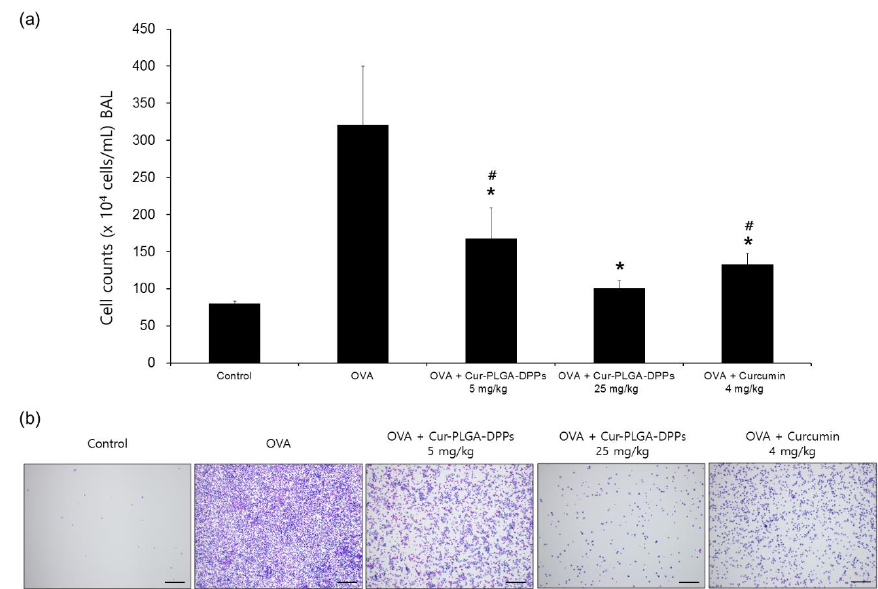
Figure 5. Effect of Cur-PLGA-DPPs on total cells in BALF; ( a ) total cell numbers and ( b ) representative photograph of BALF cells obtained through centrifugation and stained using Diff-Quick. Asterisks indicate a significant difference from the OVA group. Data are shown as mean ± standard deviation ( n = 4) * p < 0.05 compared with the OVA group; # p < 0.05 compared with the OVA + 25 mg/kg Cur-PLGA-DPP-treated group. The scale bars represent 200 µm.